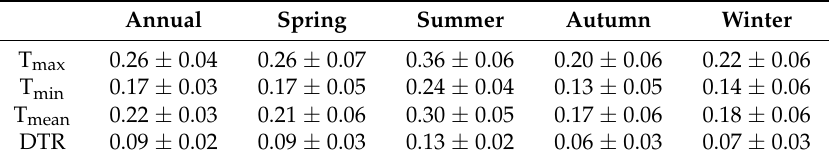
Table 2. Seasonal and annual maximum (Tmax), minimum (Tmin), mean (Tmean) air temperature and diurnal temperature range (DTR) anomaly trends ( ◦ C decade − 1 ) with the corresponding mean standard error, in Spain for the period 1950–2011. The results are significant at 99% confidence ( p < 0.01), except T min in autumn. Annual Spring Summer Autumn Winter T max 0.26 ±